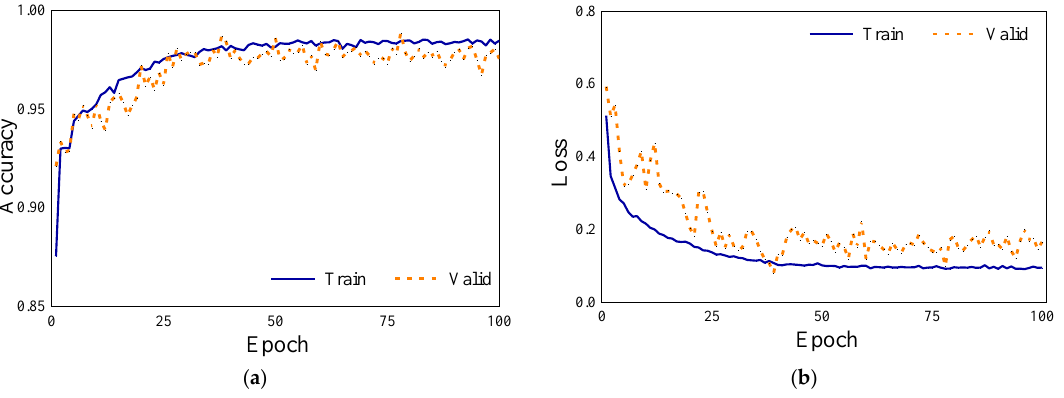
Figure 15. Accuracy and loss of the training and validation process of U-net: ( a ) accuracy; ( b ) loss.